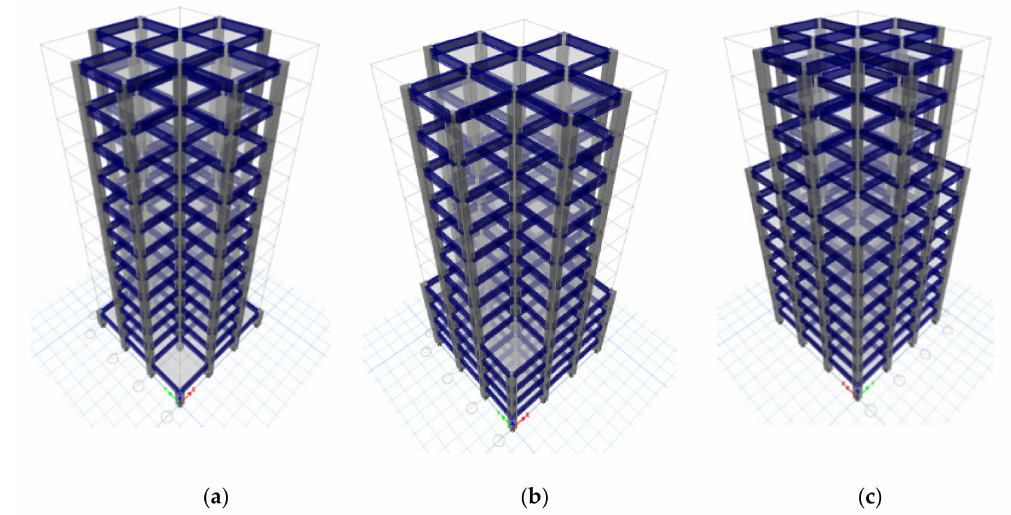
Three setback irregularity models were considered: (a) bottom setback (BSB) model, (i.e., bottom one-third of the building with setback irregularity); (b) middle setback (MSB) model (i.e., middle one-third of the building with setback irregularity); and (c) top setback (TSB) model, (i.e., top one-third of the building with setback irregularity). Table 2 and Figure 5 illustrate the details of building models with setback irregularity.